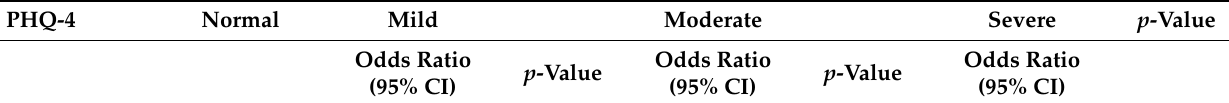
Table 4. Multivariate model. PHQ-4 score change and 95th percentile confidence interval for adjusted associations between socioeconomic status, race, and PHQ-4 score. All values were adjusted for age, sex, BMI, and smoking